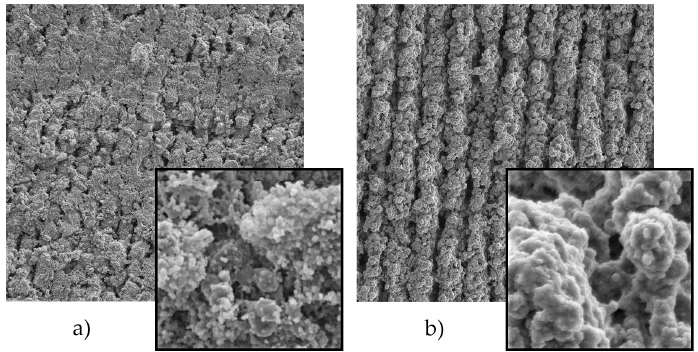
Figure 6. SEM images showing the morphology on the PTFE coating surface treated by Nd:YAG laser ablation at ф 0 = 260 J / cm 2 : ( a ) v = 100 mm / s, ( b ) v = 200 mm / s (SEM magnification ranges: big size 1000 × , small size 30,000 × ).